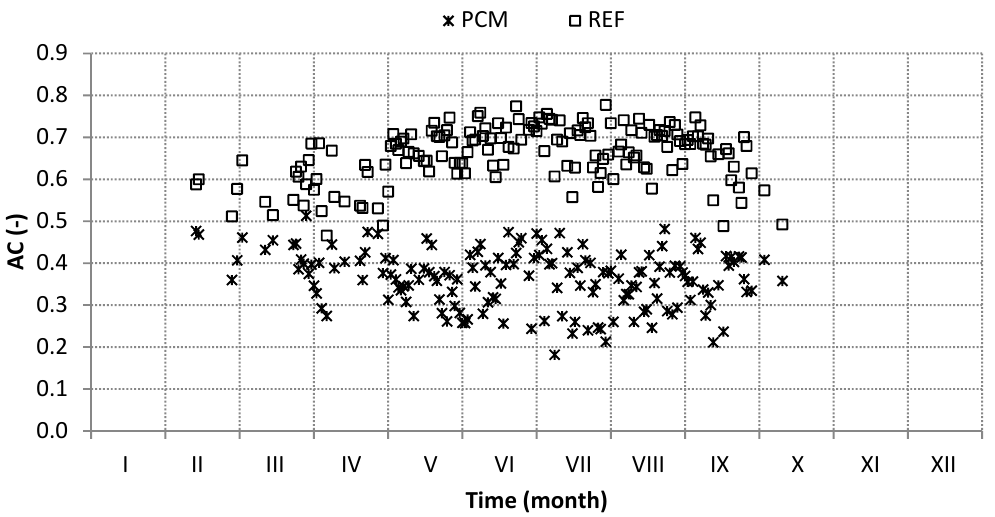
Figure 9. The AC values calculated for two test sections: PCM—modified with PCM (P4), REF— reference one (P6).